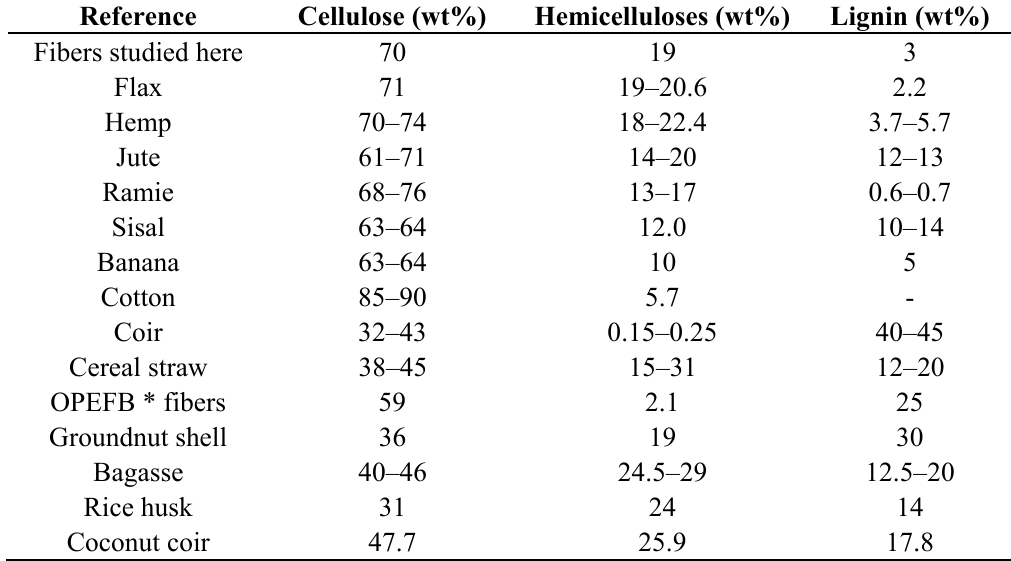
Table 2. Chemical composition of the fibers studied here compared to other types of fibers